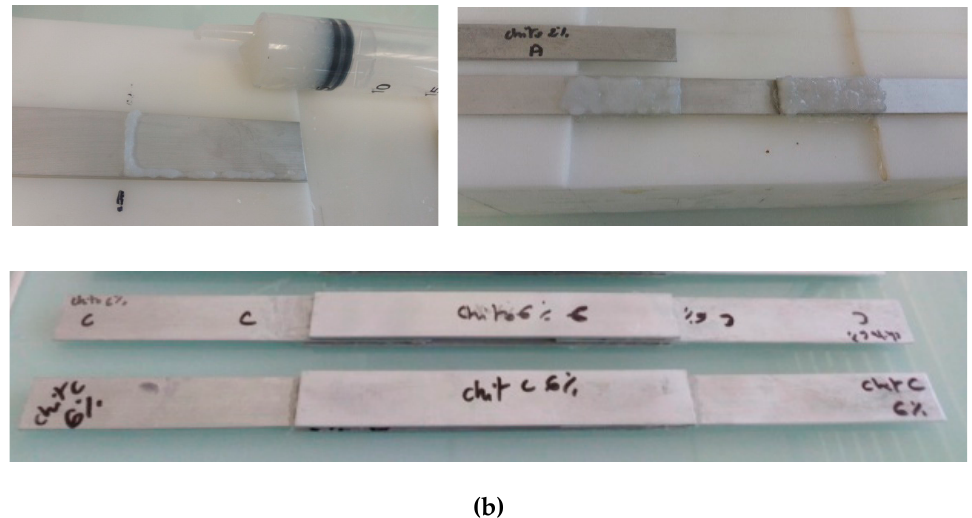
Figure 4. Illustration of bonded double-lap wood ( a ) and aluminium ( b ) specimens prepared for the mechanical characterization.